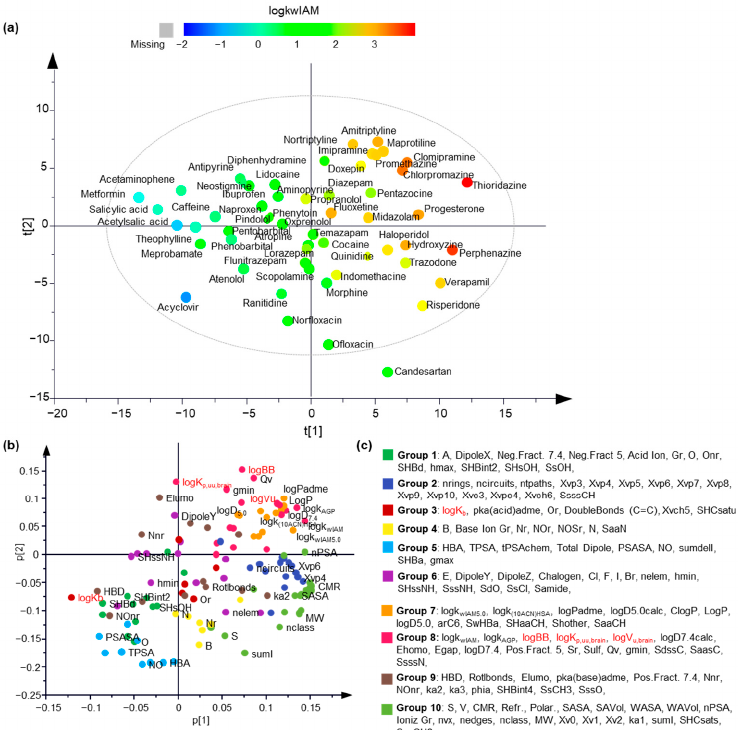
Figure 2. The unsupervised analysis provided a comprehensive overview of the data. ( a ) Scores plot of the first two principal components. The objects are colored according to a logk wIAM -based color scale; ( b ) Loadings plot of the first two principal components. The original variables are colored according to the hierarchical clustering grouping; ( c ) The grouping of the original variables based on hierarchical clustering.